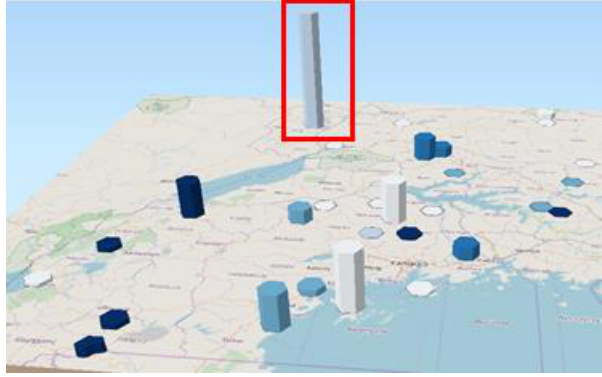
Figure 6. Human settlements "detected" by GHS for Uganda Hexagons in ellipses (Figure 5) are showing small value of H for densely populated area. This is a critical situation. It means either lower RAR, or it could also mean that OSM road data are missing. The working methodology targets this particular situation for further investigation.